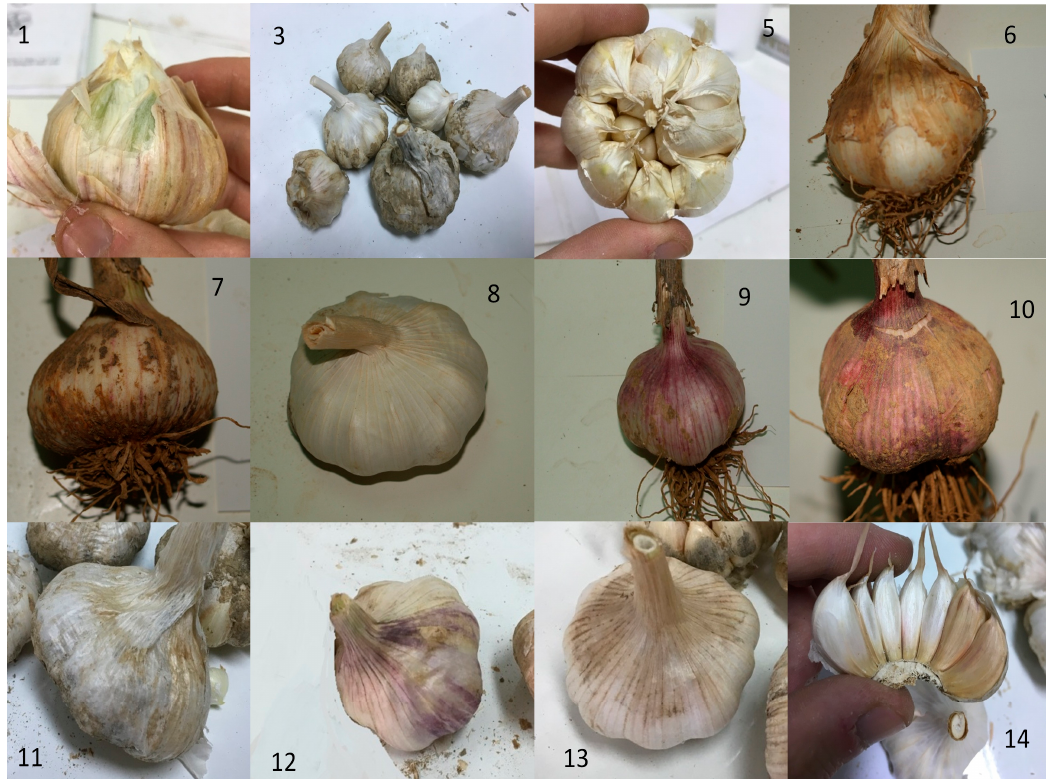
Figure 1. Pictures of selected genotypes and local landraces of the studied garlics. Numbers on each picture correspond to specific genotypes as described in the Materials and Methods section (Pictures with numbers 1, 3, 5, 8, 11, 12, 13, 14 have been offered by Mr. Nikolaos Polyzos).